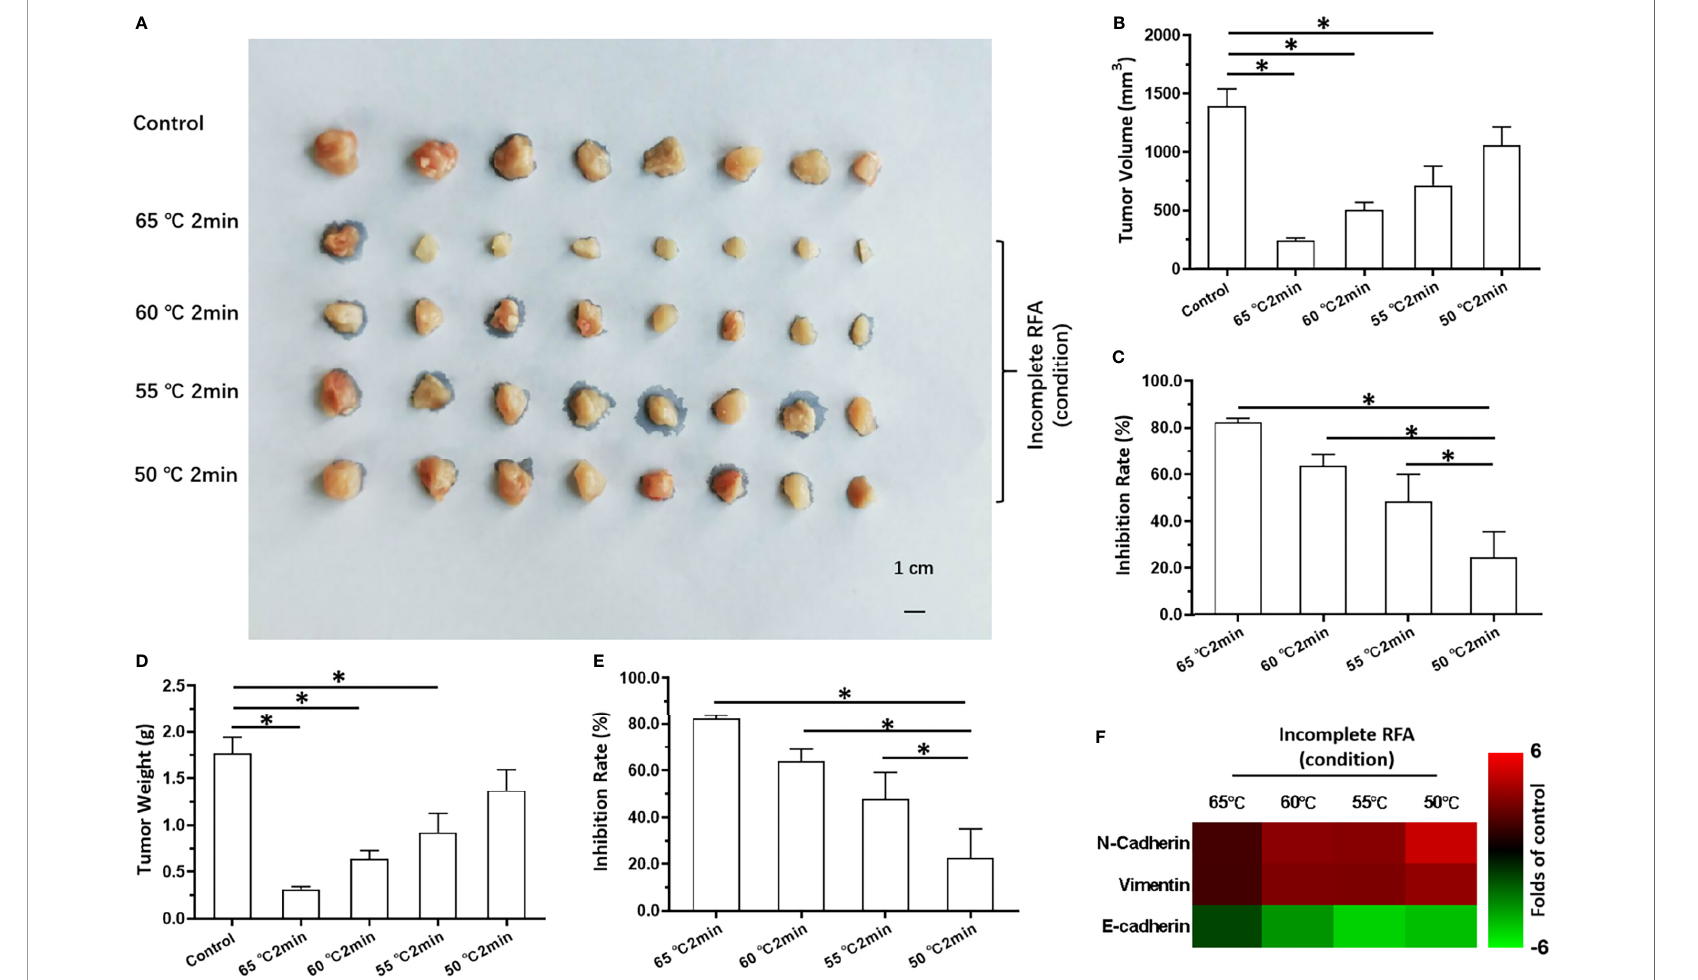
FIGURE 3 | The in vivo antitumor activation of RFA on MHCC97-H cells. The MHCC97-H cells were cultured and injected into the subcutaneous position to form the subcutaneous tumor tissues. Then, the tumor tissues were performed by the RFA (65°C, 60°C, 55°C, 50°C) for 2min. The results were shown as images of tumors (A) , the tumor volumes (B) , the inhibitory rates according to the tumor volumes (C) , the tumor weights (D) , the inhibitory rates according to the tumor weights (E) , and the heat-map (F) . *P <